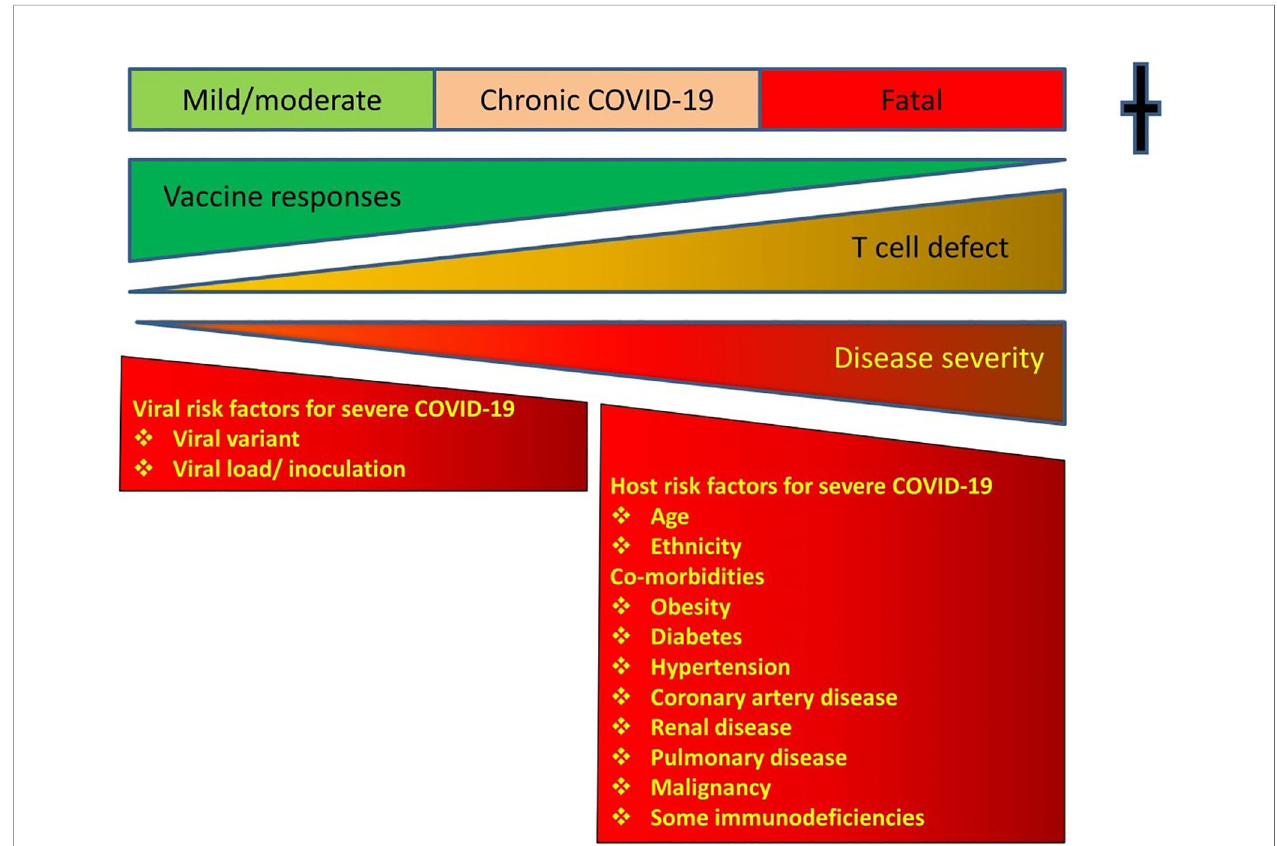
FIGURE 1 | Showing the relationship between T cell defects, responses to vaccines and outcomes. Vaccines shift the disease severity to the milder end of the spectrum. Instead of fatal disease, vaccinated patients with T cell defects will have a milder version of the infection. There is a risk of Chronic COVID-19 in immunode fi cient patients and a vigorous T cell response to vaccines shifts the disease severity to the milder end of the spectrum. COVID-19 disease severity according to WHO